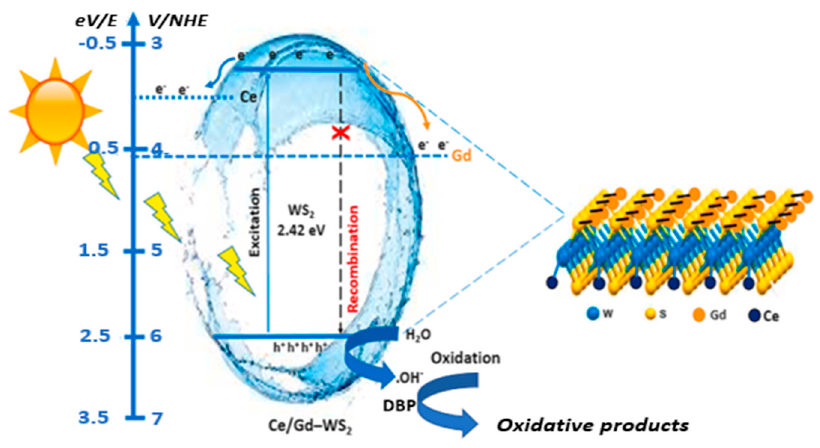
Figure 9. Proposed DBP degradation mechanism.